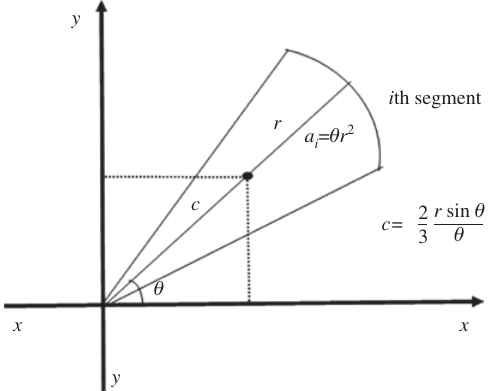
Figure 5: Features of the Ear.